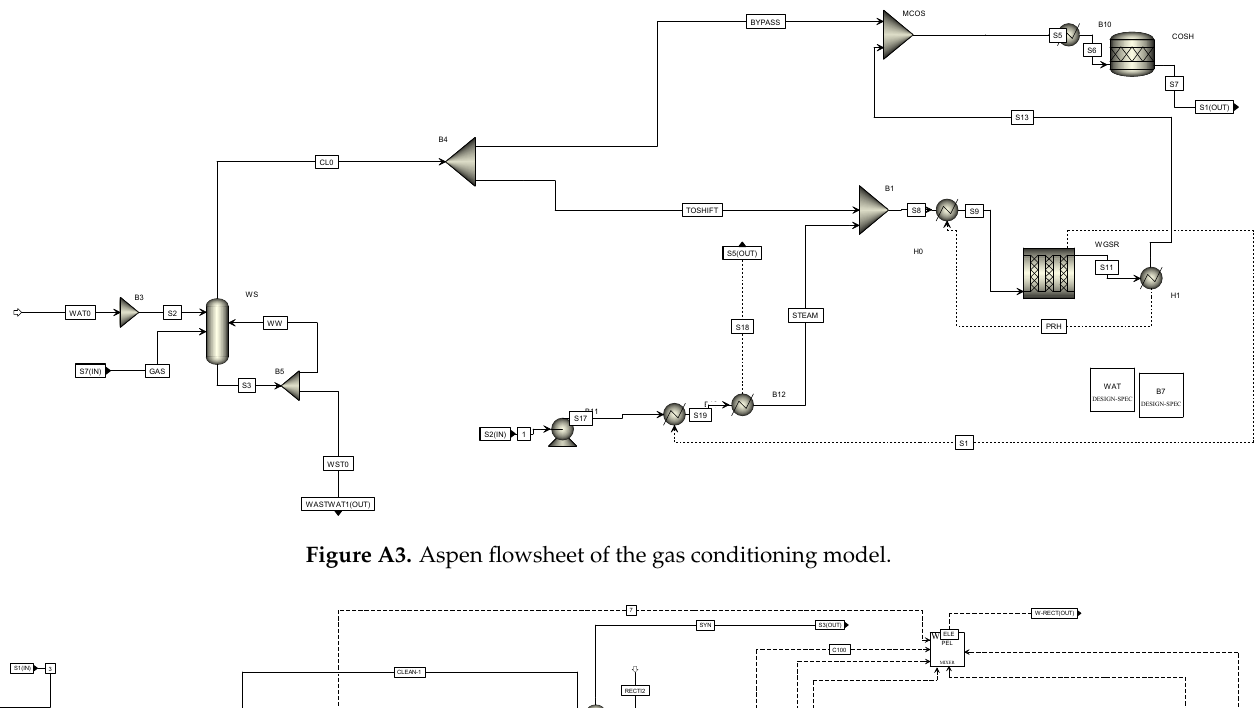
Figure A3. Aspen flowsheet of the gas conditioning model.